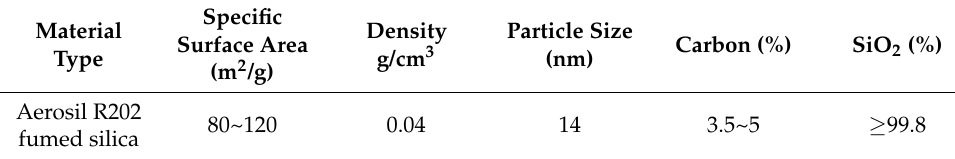
Table 3. The physical properties of fumed silica, herein PDMS modified nano